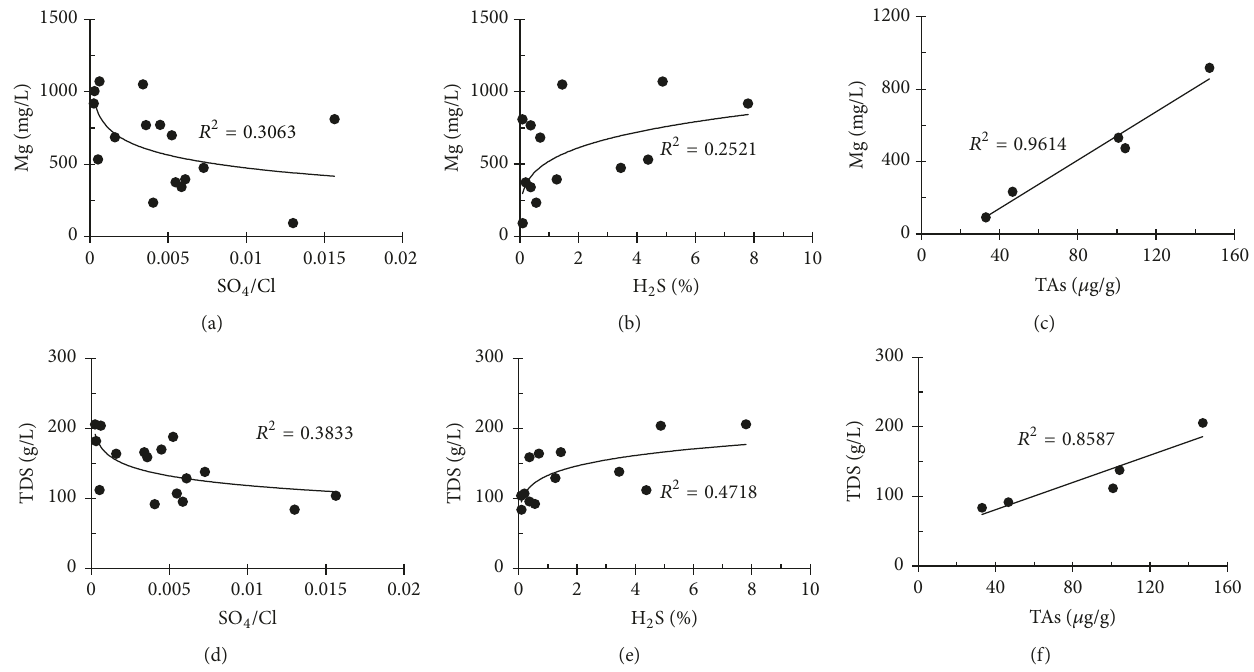
Figure 7: Relationship between (a) SO 4 /Cl ratios and Mg concentrations; (b) H 2 S concentrations and Mg concentrations; (c) TAs concentrations and Mg concentrations; (d) SO 4 /Cl ratios and TDS; (e) H 2 S concentrations and TDS; (f) TAs concentrations and TDS.